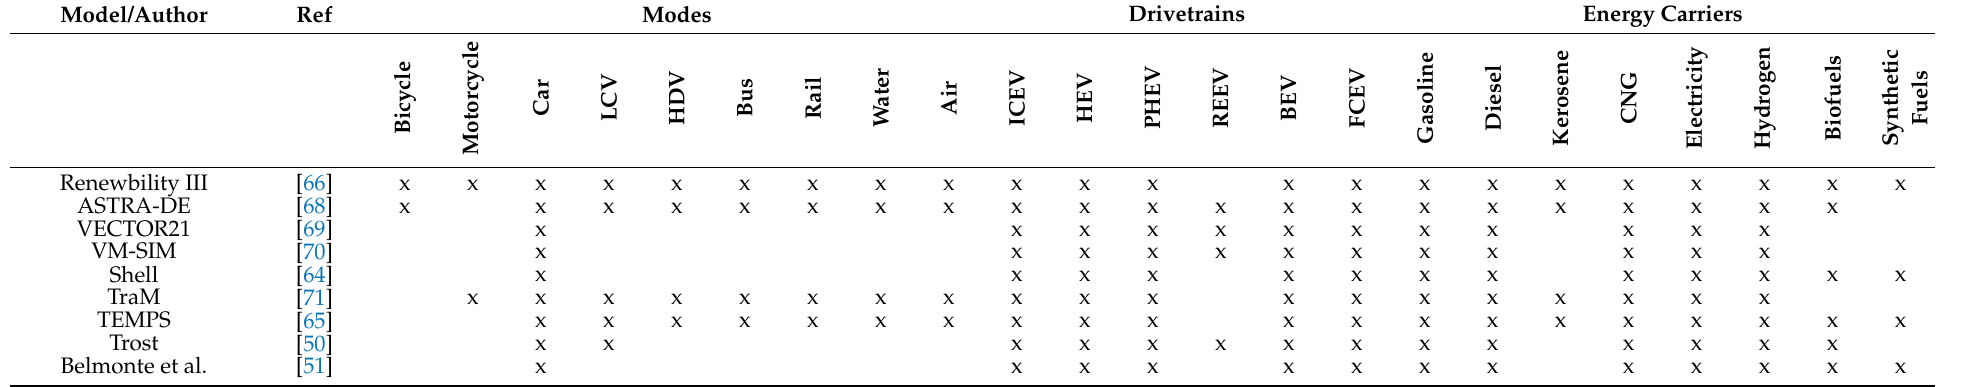
Table A2. Considered modes, drivetrains and energy carriers in investigated